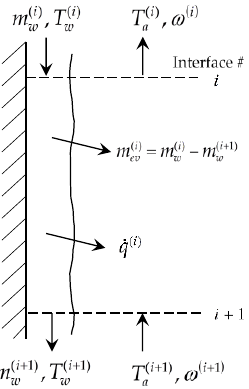
Figure 3. Heat and mass transfer between falling water film and rising air in a typical control volume of the cooling tower’s fill section.